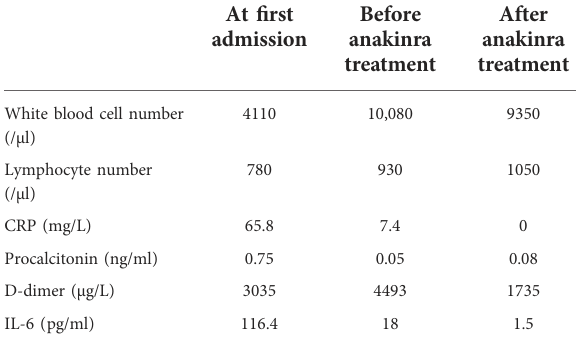
TABLE 1 Laboratory markers of COVID-19 related pericarditis in our